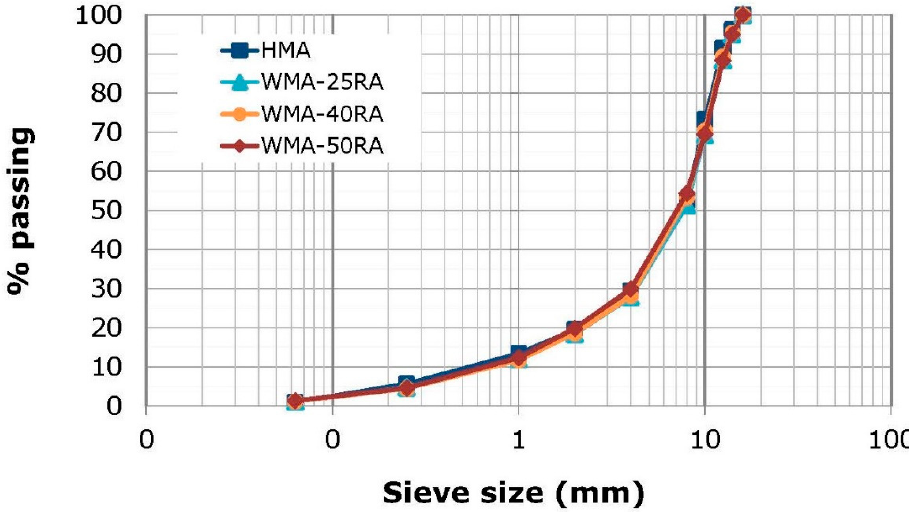
Figure 1. Grading of HMA and WMA-RA